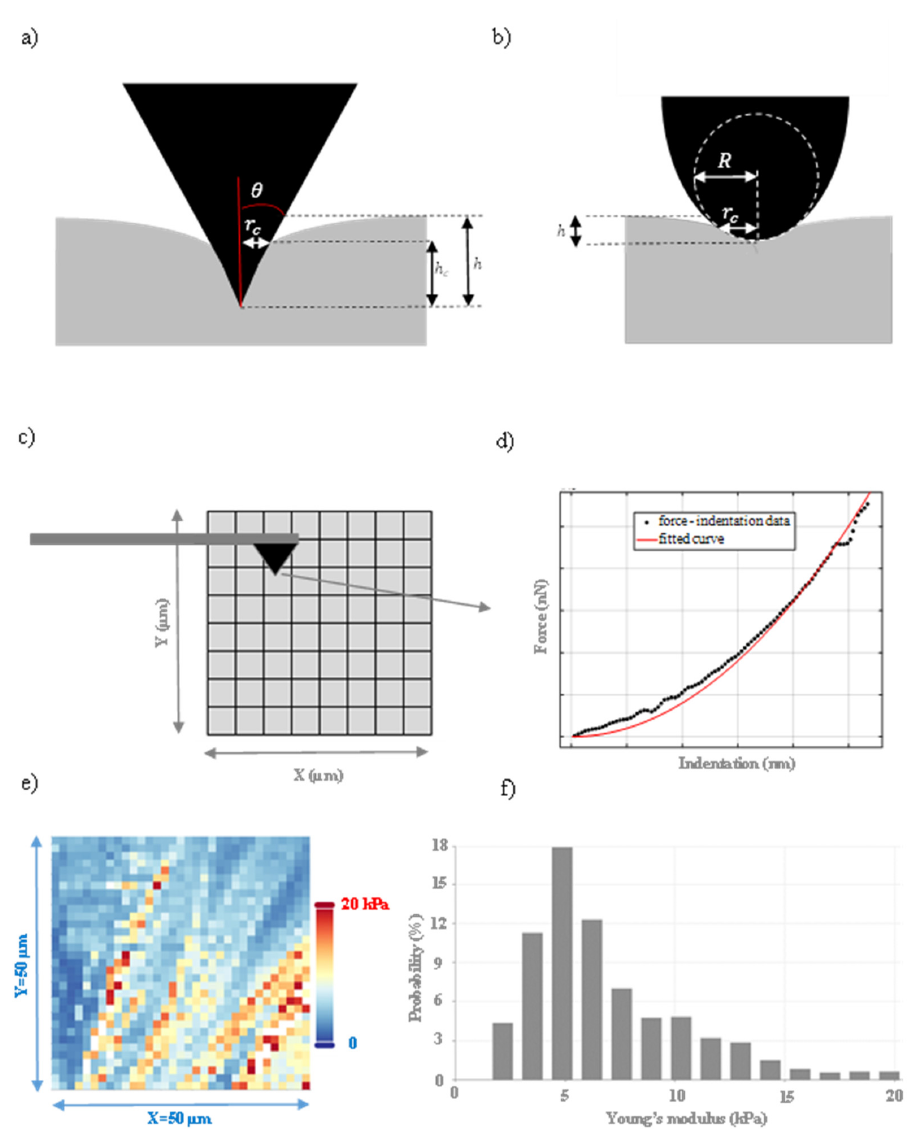
Figure 2. ( a ) A conical and, ( b ) a parabolic indenter, indenting an elastic half space. ( c ) Illustration of the procedure for obtaining a Young’s modulus map. The area of interest is divided to many nanoregions. ( d ) Force–indentation data is obtained on each nanoregion and is fitted to the appropriate model of Hertzian mechanics (Equations (1)–(5)). ( e ) A Young’s modulus map obtained on a fibroblast (using open access nanoindentation data obtained with a conical indenter (cone’s half angle 25° and cantilever’s spring constant 0.01 Nm − 1 ) [29]). Only the first 800 nm of the force-indentation data was fitted to Equation (9) to avoid the possibility of a substrate effect. ( f ) The ‘probability-Young’s modulus’ graph. This graph shows the extended heterogeneity of the